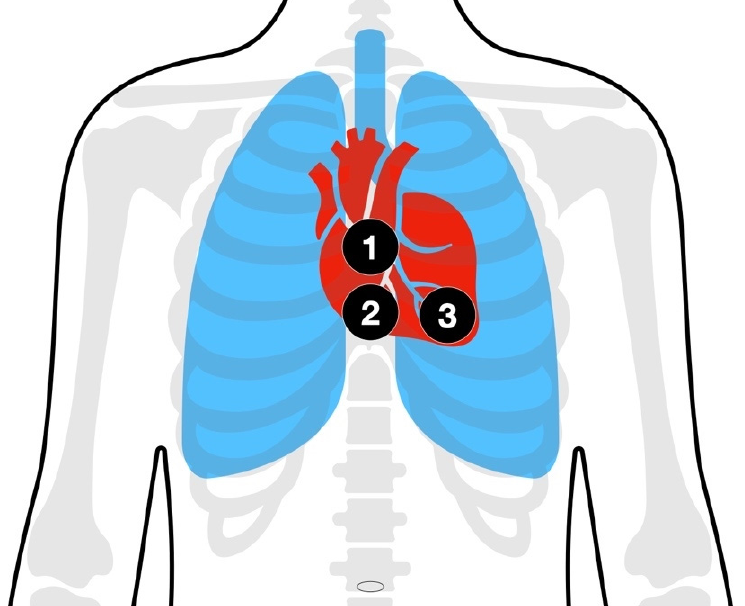
Figure 1. Schematic diagram of chest compression points. ( 1 ) “classic” hand position according to current guidelines [11,32]; ( 2 ) a more caudal approach with the hand still on the sternum; ( 3 ) a more caudal and left lateral approach in order to provide the maximum compression upon the left ventricle (LV).